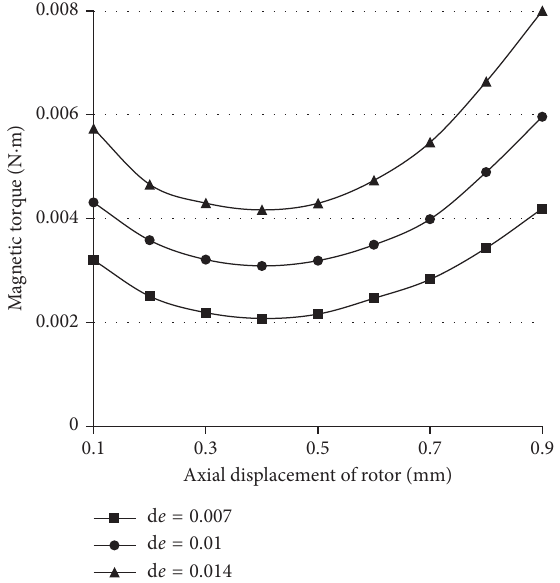
Figure 7: Radial forces of magnetic bearings acting on the rotor in different axial positions and radial eccentricities.